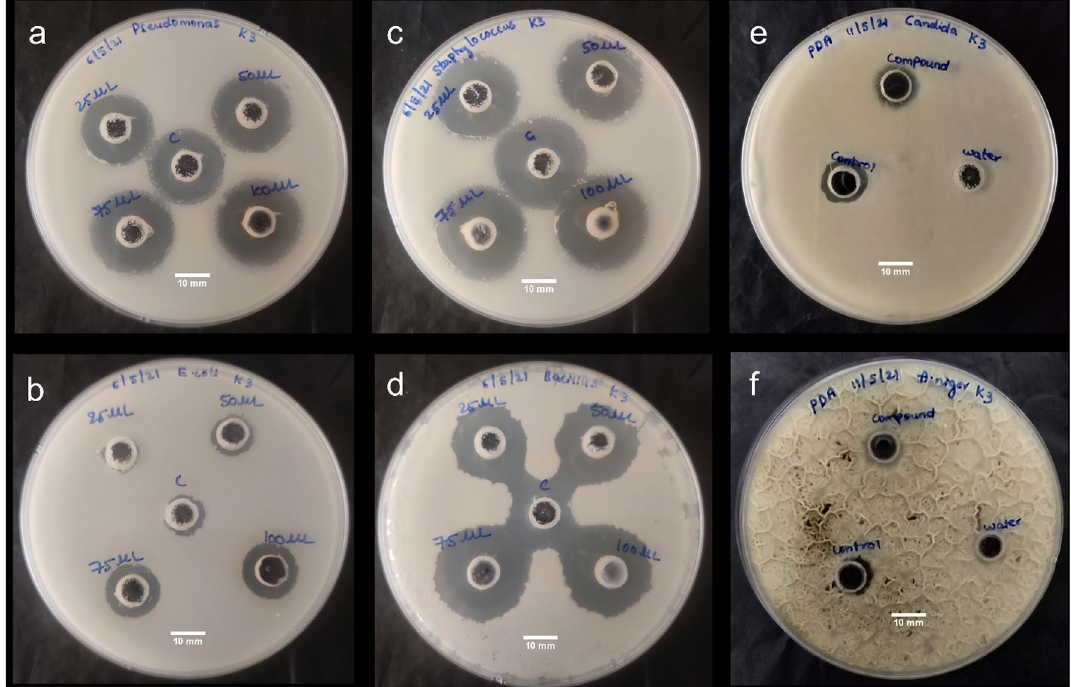
Figure 4. Antimicrobial activity of CDs ( a , b ) Antibacterial assay: Zone of inhibition against Staphylococcus aureus and Bacillus subtilis (gram-positive bacterial strains) and ( c , d ) Escherichia coli and pseudomonas aeruginosa (gram-negative bacterial strains), respectively ( e , f ) Zone of inhibition against candida and Aspergillus Niger (fungal strains) (scale bar is 10 mm for